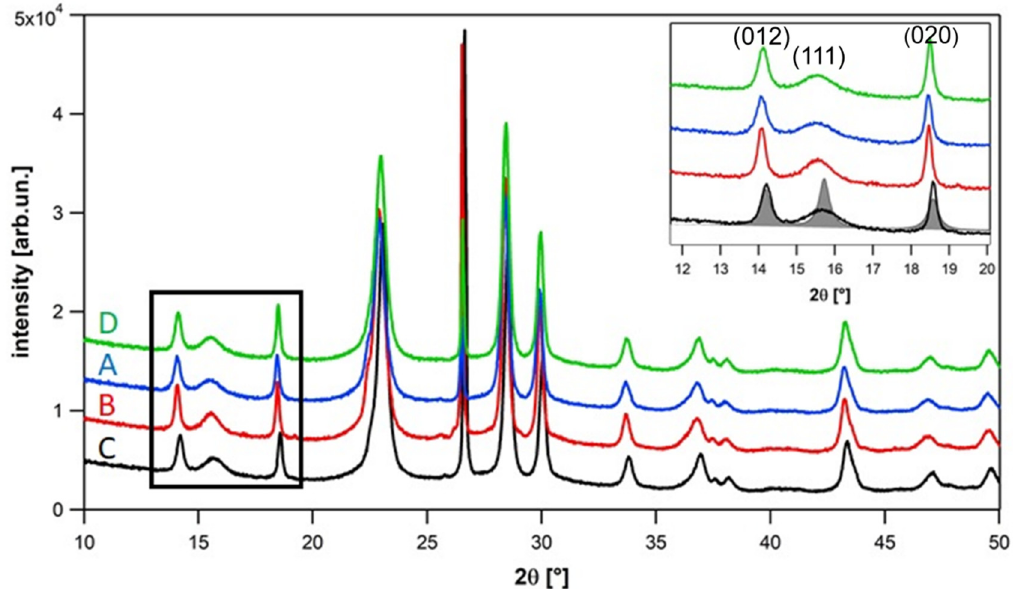
Figure 1. X-ray powder diffraction patterns of the catalyst samples (A–D) with increasing catalytic performance measured in the range of 10–50° 2 Θ with CuK α radiation. The inset displays the broadening of the VPP (111) reflection of the measured diffractograms and a calculated pattern (dark grey) for